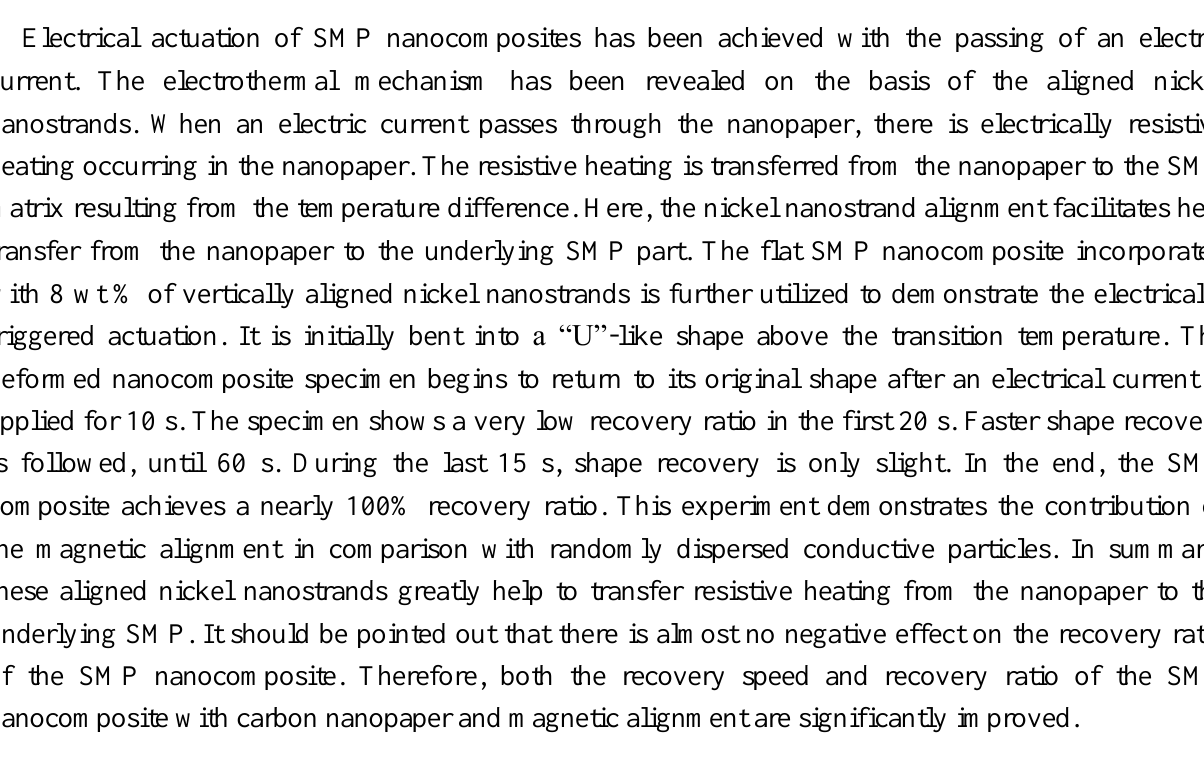
Figure 6. SEM image of the orientation of the nickel nanostrands observed via the thickness of the SMP nanocomposite. Reproduced with permission from [41]. Copyright 2011 RSC